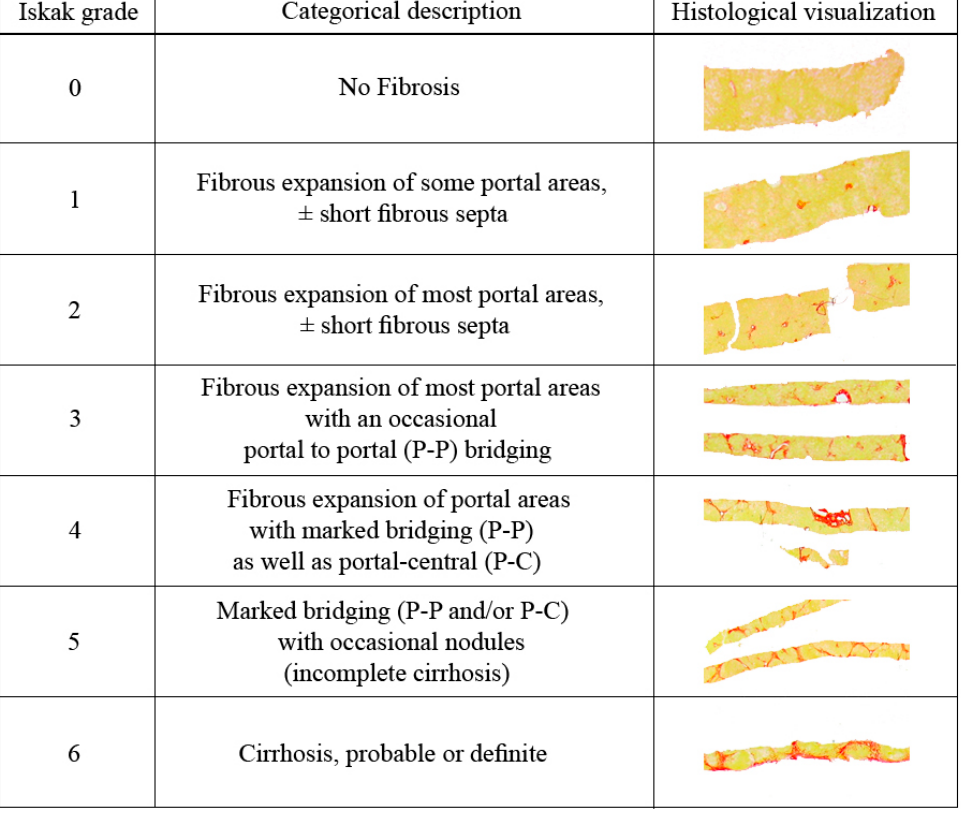
Figure 2. Illustration of the Ishak system stages (0–6) on histologically stained Sirius red (SR) tissue sections.